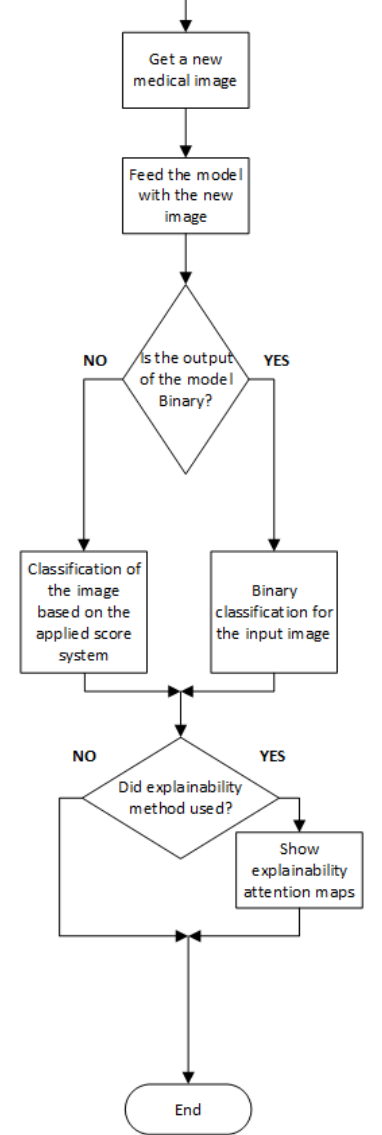
Figure 3. General block diagram for testing the CNN models.